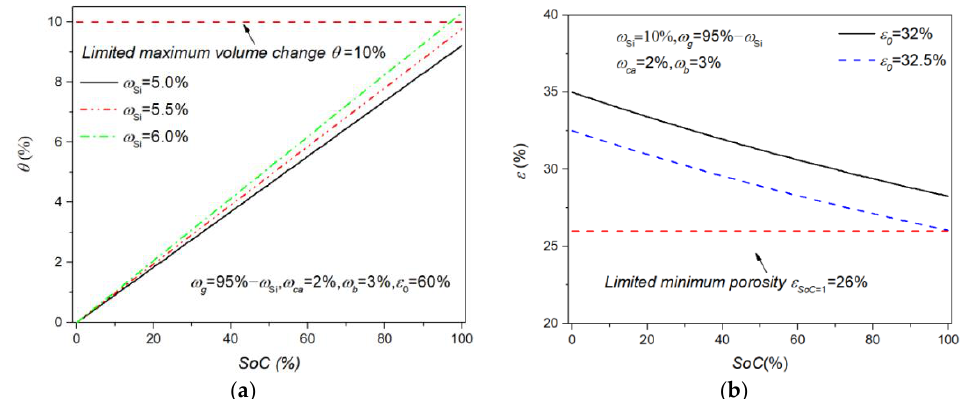
Figure 5. The evolution of ( a ) the change in electrode dimensions with ε 0 = 60% for different ω Si and ( b ) the porosity of electrodes with ω Si = 10% for different ε 0 .